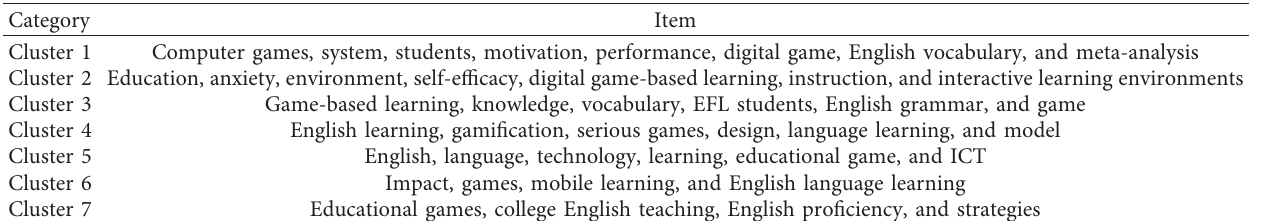
Figure 2: Cluster of keywords. Table 1: Cluster of keywords.